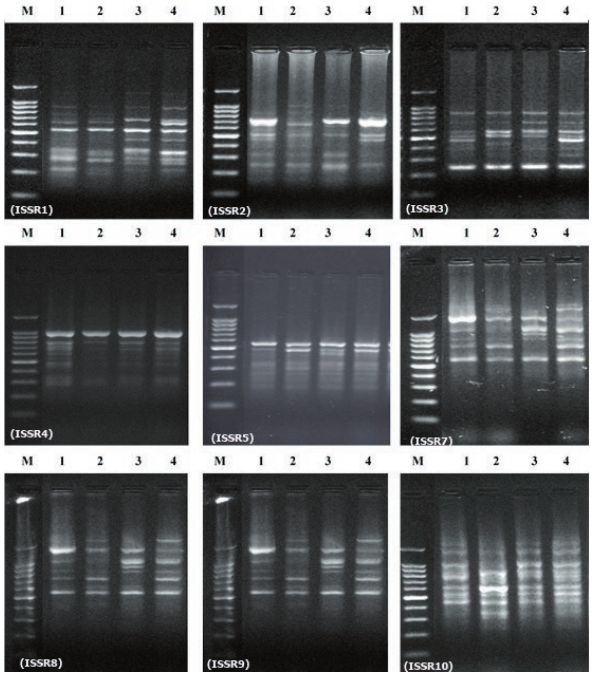
Figure 3. ISSR-PCR profiles generated by 9 primer using roots of different V. faba Misr 3 cultivar subjected for different periods in 5 mM AlCl 3. Lanes1, 2, 3 and 4 (0.0, 6, 12 and 24hr), respectively. M: DNA ladder.